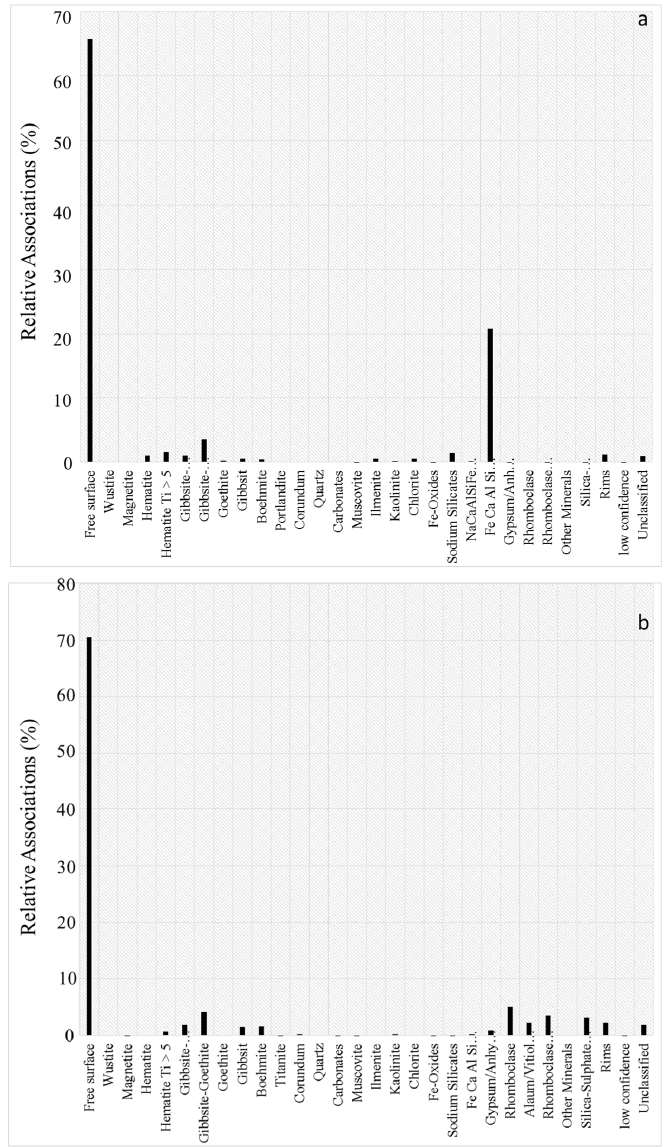
Figure 5. Mineral association of TiO 2 within: ( a ) red mud; ( b ) H 2 SO 4 leach residue.